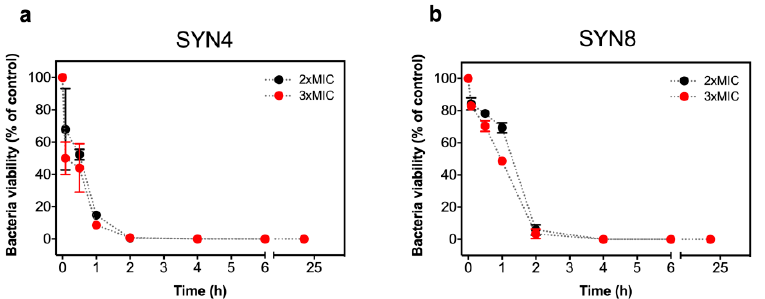
Figure 4. Killing kinetics of Klebsiella pneumonia SYN4 OXA-48 ( a ) and SYN8 KPC ( b ) clinical isolates induced by L-OEI-h. The killing kinetics was evaluated with a colony count assay using two different oligomer concentrations, 2 × MIC and 3 × MIC.